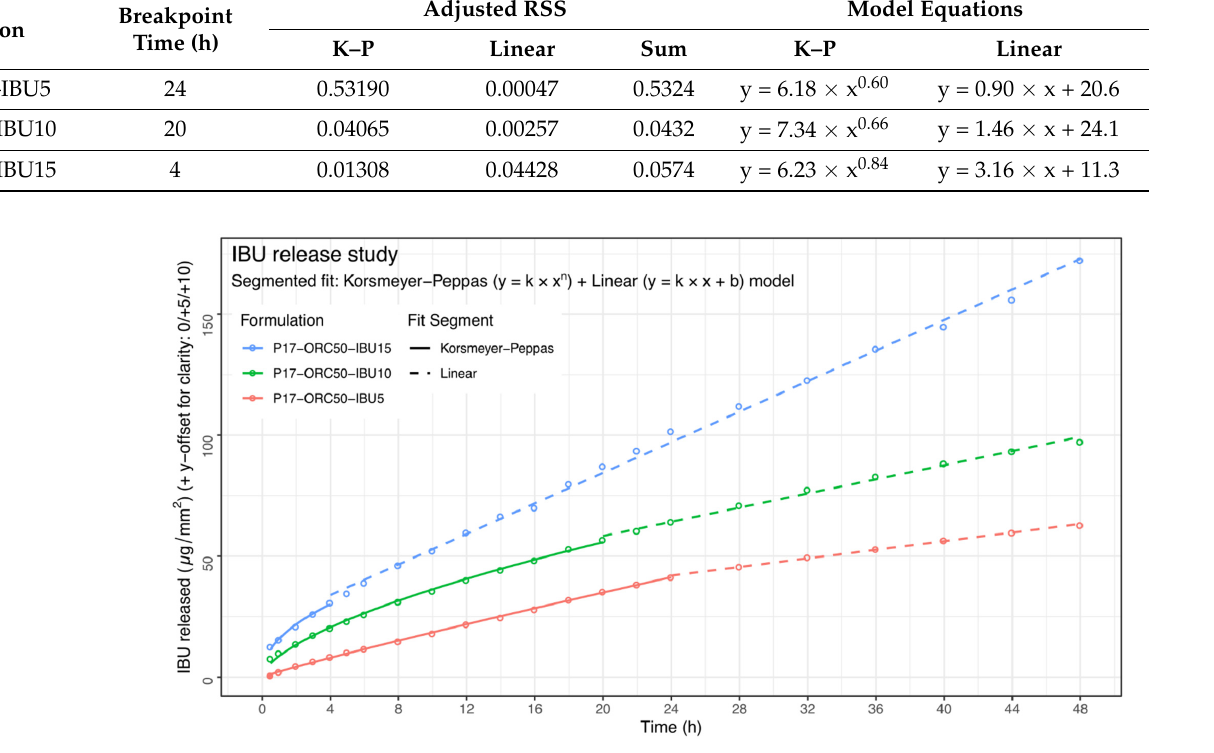
Figure 13. IBU release results with segmented regression lines overlaid. Notice the y-offset applied in different series: +5 and +10 for P17–ORC50–IBU10 and -IBU15, respectively. Table 9. A summary of segmented fit results.